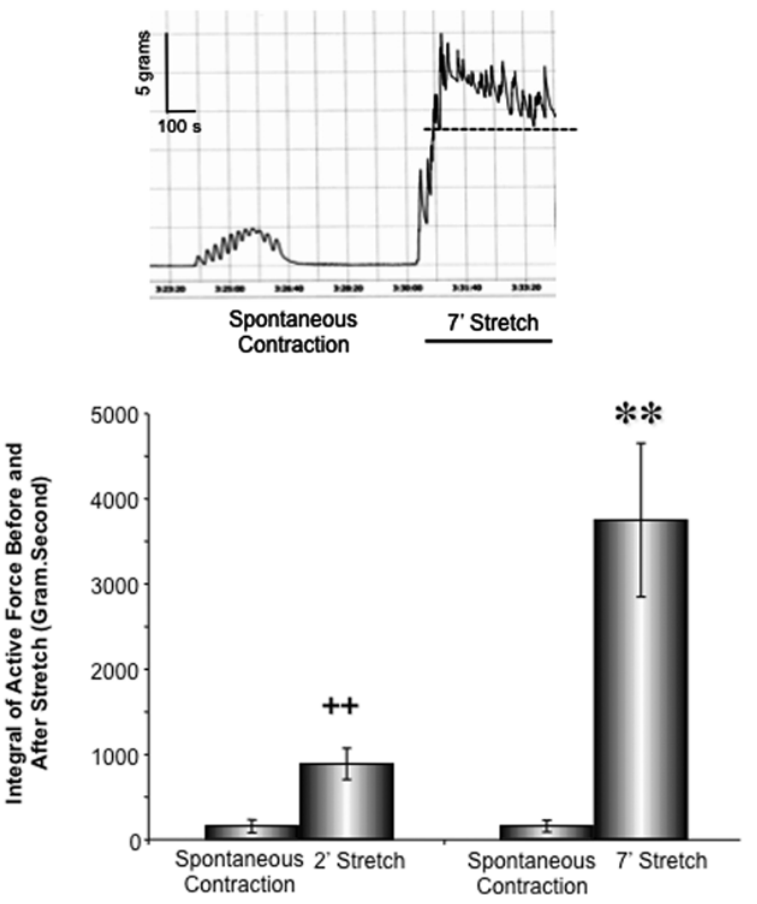
Figure 3. Invitro stretch increases contractility in pregnant myometrium. Uterine contractility was measured and quantified as the area under curve (AUC). AUC is the integral of the active force over a period time of 2 or 7 minutes before and after stretch. Dotted line indicates level of passive stretch. Data presented in the bar graph were collected from 8 term, not in labor, pregnant human myometrial samples and total 17 smooth muscle strips. ++ p , 0.01 compared to the AUC of spontaneous contraction before 2 minute-stretch. ** p , 0.01 compared to the AUC of spontaneous contraction before 7 minute-stretch. An insert was the representative myograph recording of contractile force from term pregnant human myometrium in response to in vitro